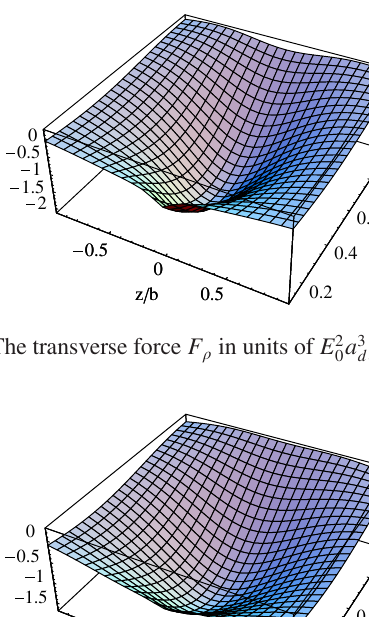
FIG. 9. Dependence of the longitudinal force F = δ . F parameter p ¼ a is calculated at z=b ¼ 0 . 1 The red d z and blue curves for p ¼ 0 . 1 and p ¼ 5 . 0 , respectively. Trans- < 0 verse stability corresponds to F z